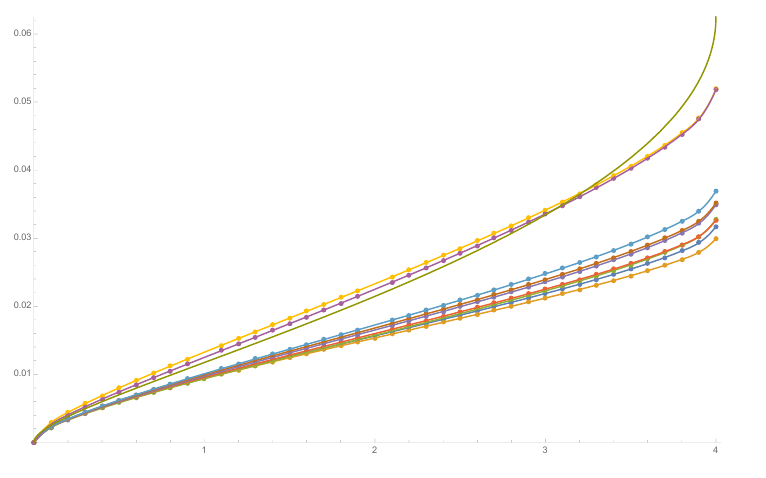
Figure 7 . Results for the ratio A (cid:8) =A (cid:8) , as a function of Q , for sizes L = h 3 = 2 ; (cid:0) 2 ;h 3 = 2 ; 2 h 1 = 2 ; (cid:0) 2 ;h 1 = 2 ; 2 5 ; 6 ; 7 ; 8 ; 9 ; 10 ; 11 corresponding to colours blue, orange, green, red, purple, mauve, clear blue. The points in purple are obtained by extrapolating data for L = 5 ; 7 ; 9 ; 11 and those in yellow by extrapolating data for L = 6 ; 8 ; 10. The green curve is the conjecture